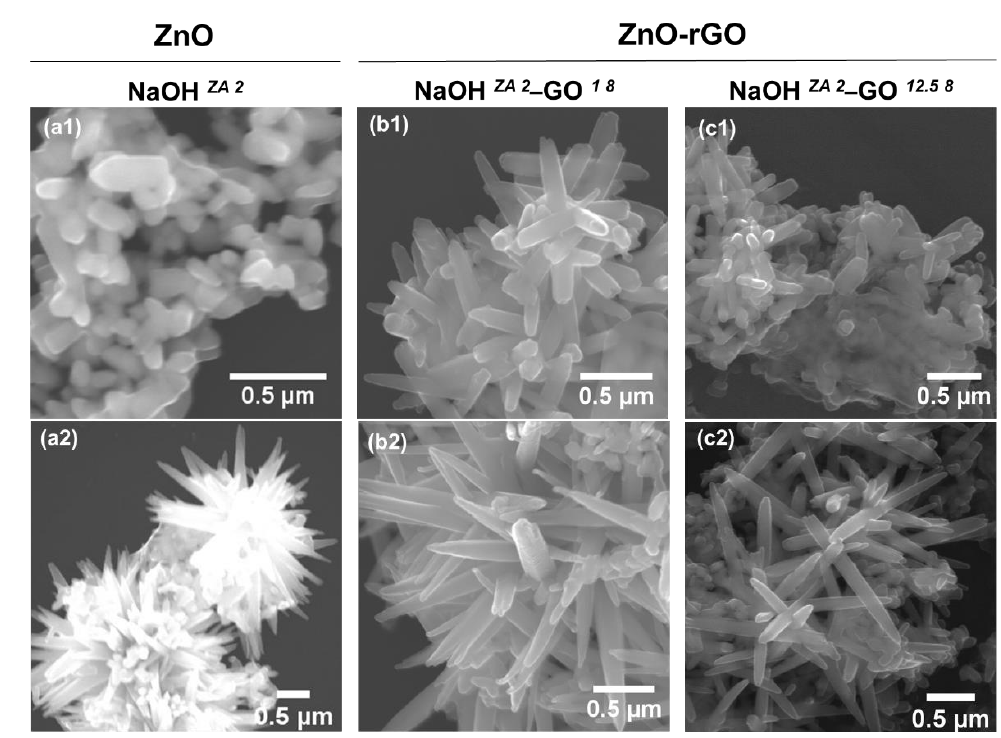
Figure 5. SEM micrographs of ZnO (NaOH ZA 2 ( a1 , a2 )) and ZnO–rGO structures varying the concentration of GO suspension: 1 mg/mL (NaOH ZA 2 –GO 1 8 ( b1 , b2 )) and 12.5 mg/mL (NaOH ZA 2 –GO 12.5 8 ( c1 , c2 )).